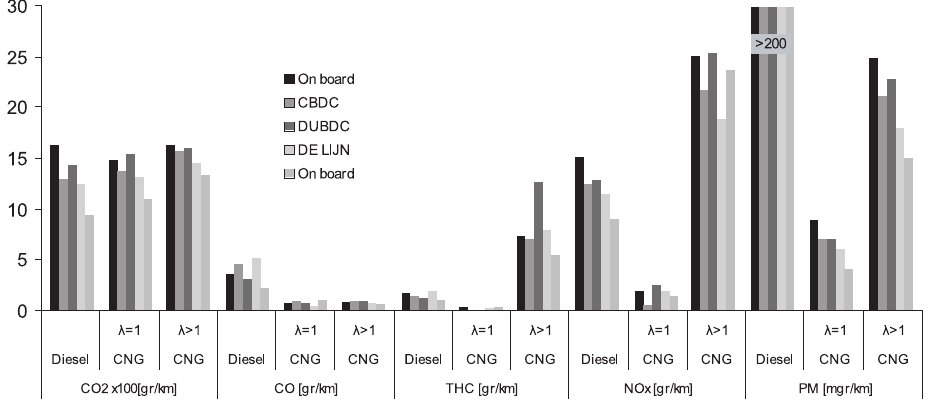
Fig. 1. The emission of harmful gases of different buses under different conditions of exploitation (Pelkmans et al. 2001)